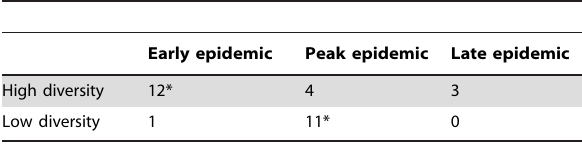
Table 1. Significant differences in amino acid diversity between intraseasonal periods.